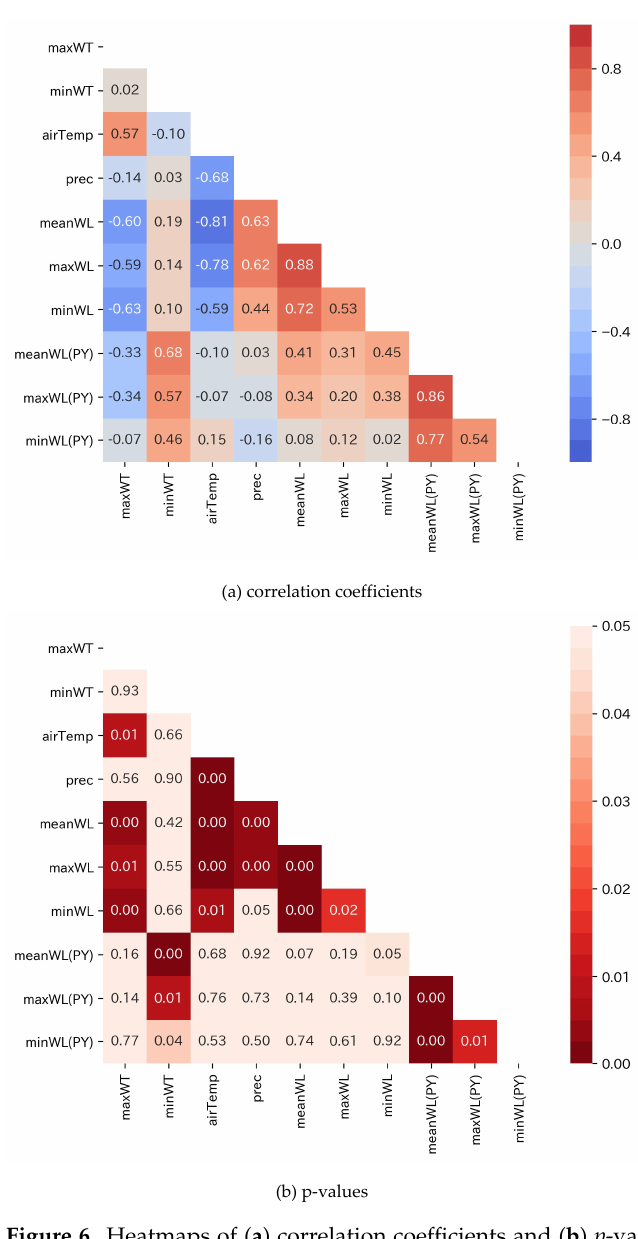
Figure 6. Heatmaps of (a) correlation coefficients and (b) p-values between variables. In (a), red indicates a positive correlation while blue indicates a negative correlation. Abbreviations: maxWT: maximum water temperature, minWT: minimum water temperature, airTemp: air temperature, prec: precipitation, meanWL: mean water level, maxWL: max- imum water level, minWL: minimum water level, meanWL (PY): mean water level in the previous year, maxWL (PY): maximum water level in the previous year, and minWL (PY): minimum water level in the previous year.